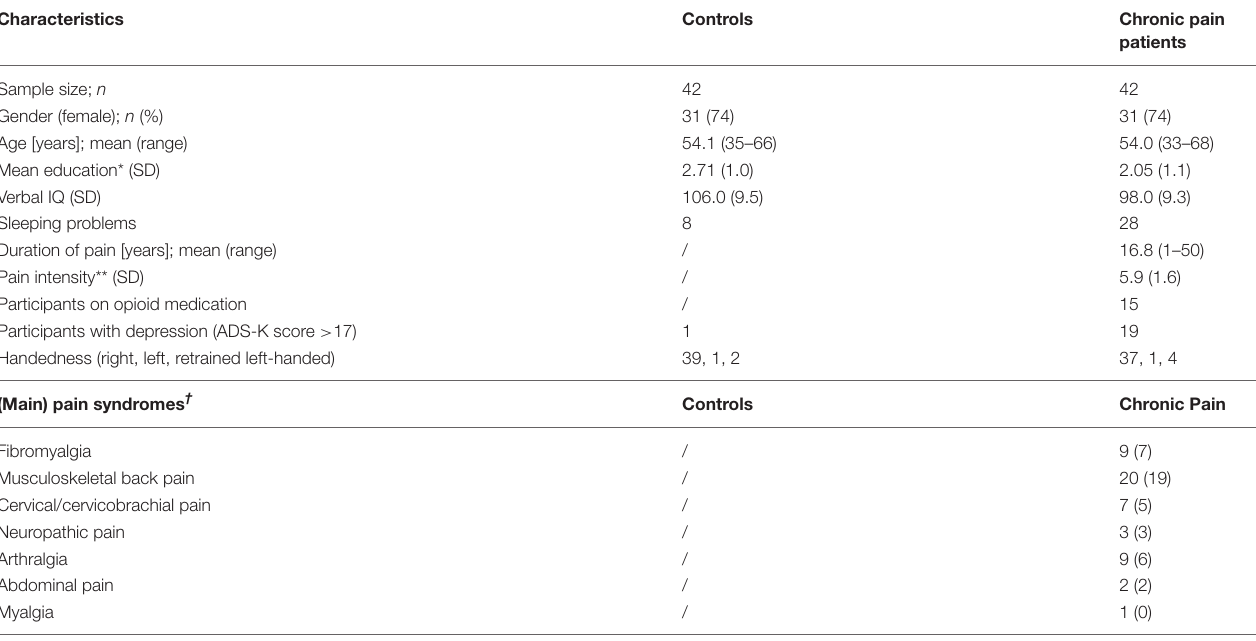
TABLE 1 | Characteristics of participants.